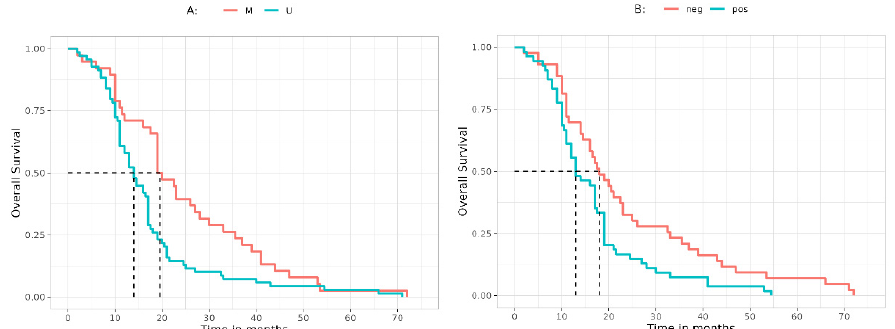
Figure 2. OS curves representing the survival of patients (in terms of months) on the basis of MGMT. ( A ) OS evaluated on MGMT methylation status. Dashed vertical lines: median survival times are 19.5 months for M and 14.0 for U. ( B ) OS evaluated on MGMT expression by IHC. Dashed vertical lines: median survival times are 18 months for neg and 13 months for pos groups. Abbreviations: IHC, immunohistochemistry; M, methylated; neg, negative; OS, overall survival; pos, positive; U, unmethylated.